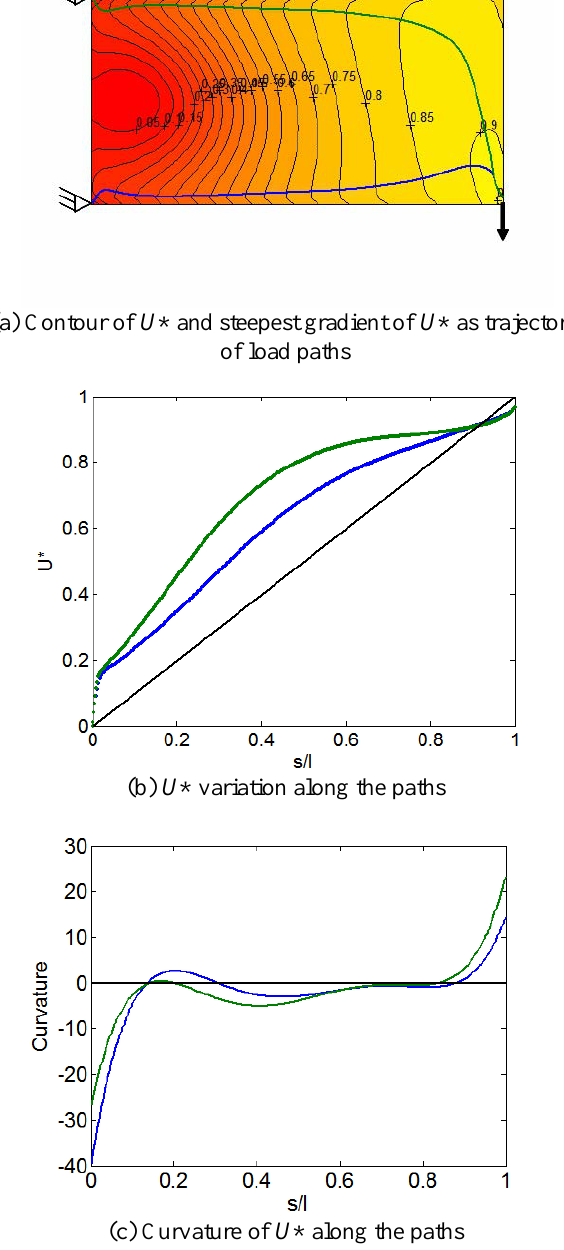
Fig. 12. Load paths based on U *. Green indicates upper path and blue indicates lower